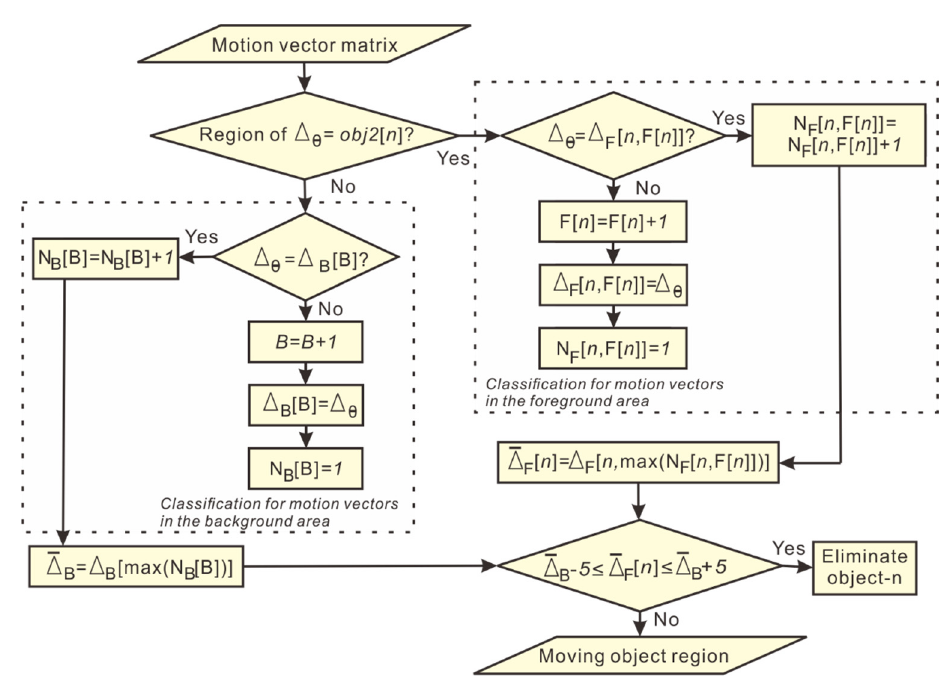
Figure 7. Flowcharts to classify motion vectors and select moving objects.